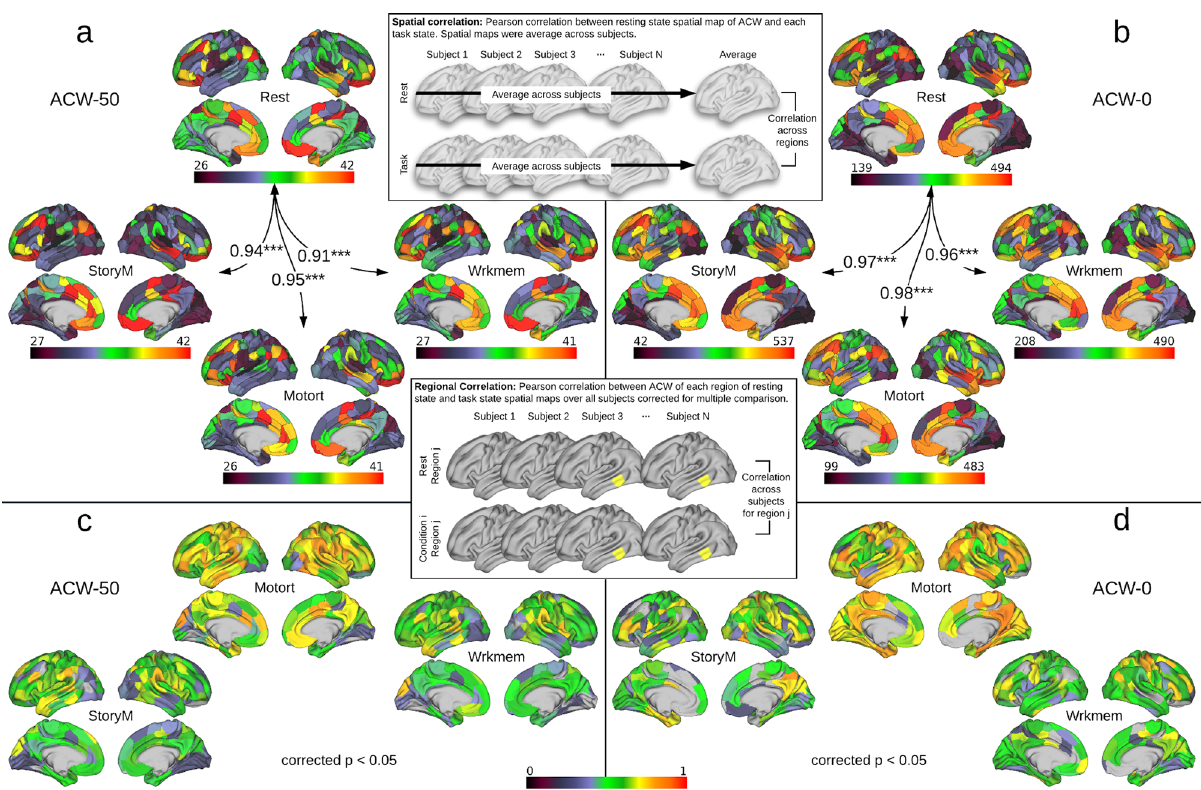
Fig. 5 The spatial similarity between resting and task states. The similarity was calculated by applying rest – task spatial correlation ( a , b ) and intra- regional rest – task correlation ( c , d ). The boxes with the gray brains show how spatial and regional correlation was calculated. The yellow region in the box of regional correlation is a sample region chosen only for illustration purpose. a , b Show spatial correlation (numbers on the arrows) between different conditions alongside their spatial distribution over brain regions for ACW-50 and ACW-0, respectively. Each value on the arrows is a Pearson correlation coef fi cient between a pair of conditions across the brain regions ( n = 360). All correlation values suggest that different conditions are highly correlated with each other (*** ≡ α = 0.001). c , d Show the regional correlation between resting and each task state in ACW-50 and ACW-0, respectively. Pearson correlation coef fi cients were calculated for each region over different subjects, then corrected for multiple comparisons using the FDR correction method at α = 0.05. Only the regions that survived the correction are